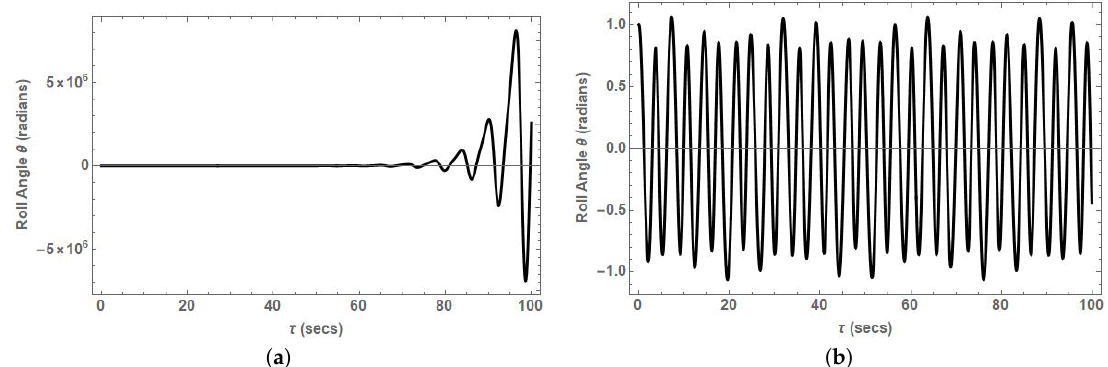
Figure 9. Comparison of roll angle variations of the SSF system with significant linear damping and no rotational damper ( a ) when q t = 0.5, a = 1.0, ( b ) when q t = 1.5, a = 1.0. Similarly, the roll angle variations for the SSF system with significant linear damping and an additional rotational damper ( C = 0.20) is evaluated and plotted in Figure